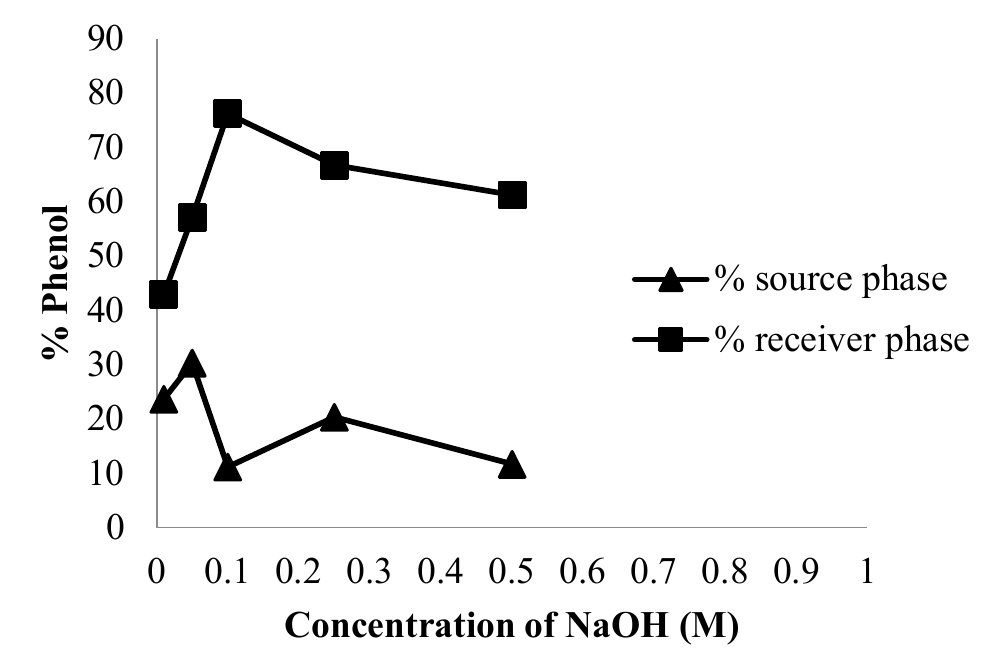
Figure 3. Phenol transport curves on the effect of NaOH concentration.